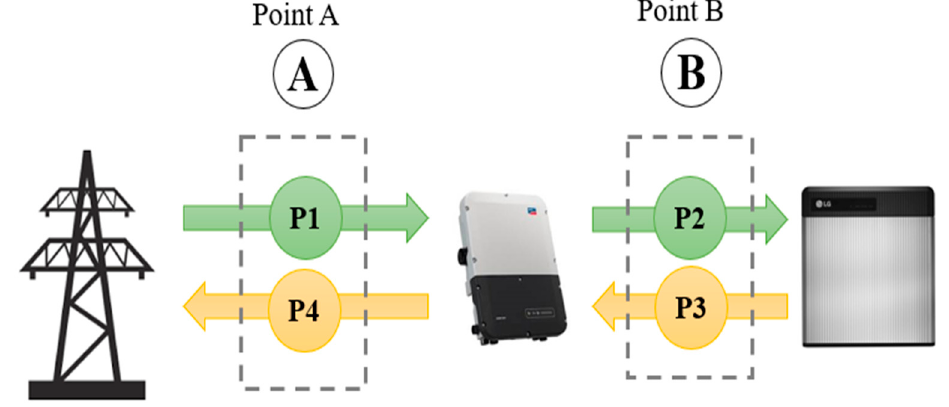
Figure 4. Electric circuit schematic and measuring points in the bidirectional grid–inverter–battery power flow.